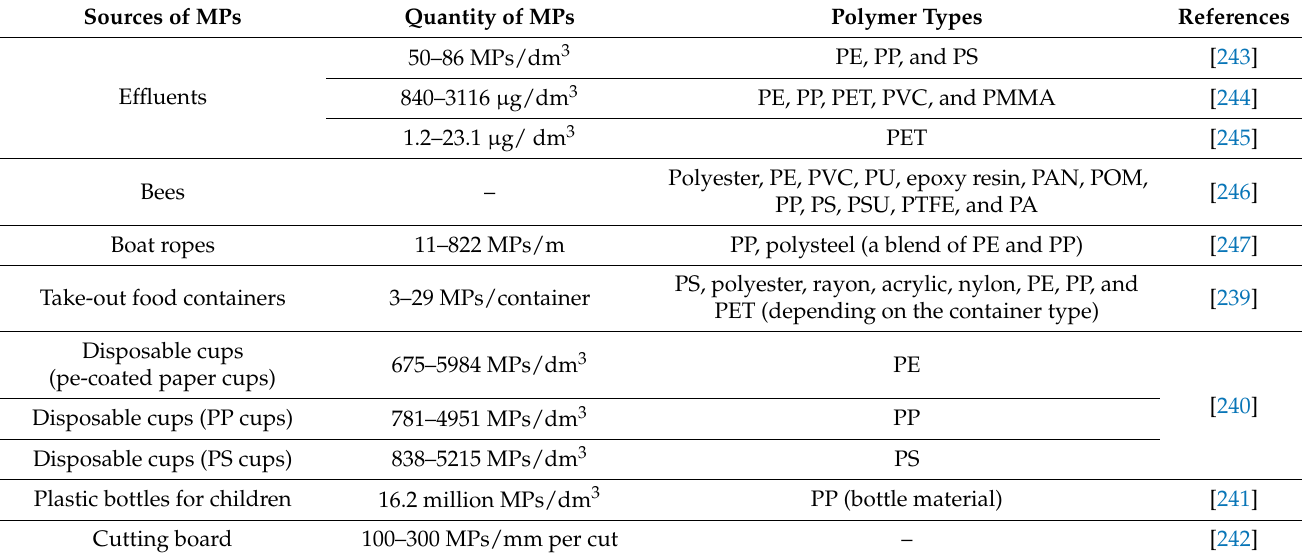
Table 4. The origin of MPs from various individual